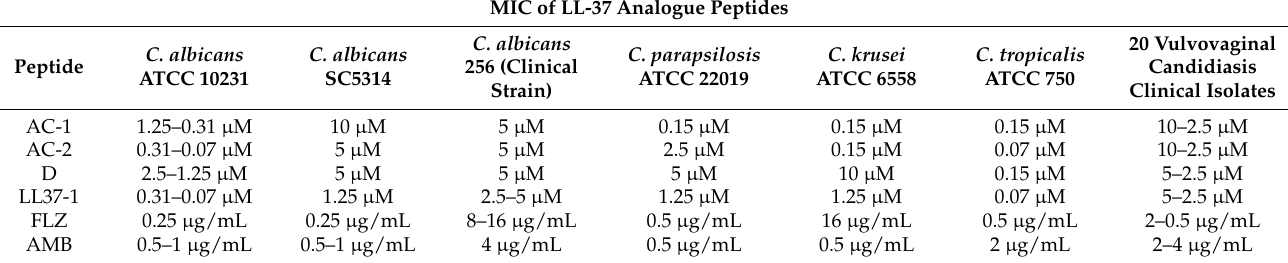
Table 1. Minimum inhibitory concentration (MIC) values of the AC-1-, AC-2-, D-, and LL37-1-derived peptides (expressed in µ M). Amphotericin B (AMB) and fluconazole (FLZ) (expressed in µ g/mL) were used as antifungal controls. Twenty vulvovaginal candidiasis samples, representing the combination of all clinical isolates in this